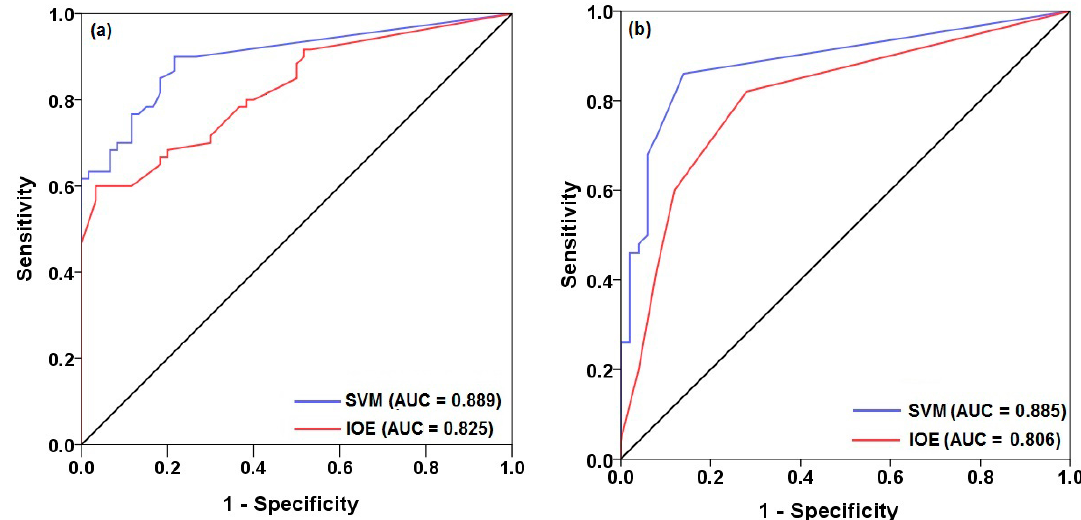
Figure 11. Success and prediction accuracy rate curves of the SVM and IOE models used in landslide susceptibility mapping.